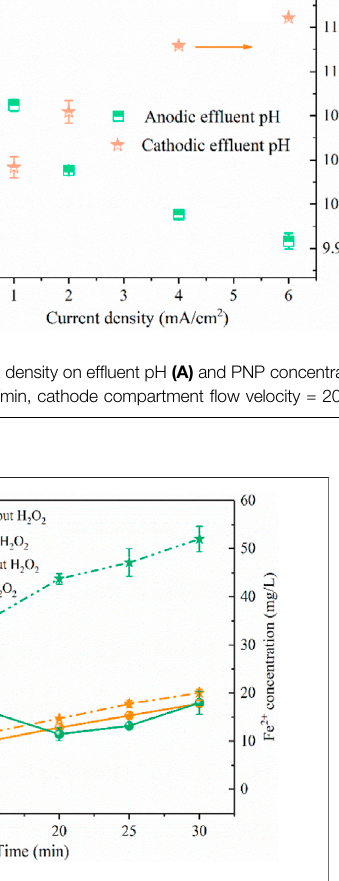
FIGURE 3 | Concentration variations of iron ions under different conditions. (PNP (cid:1) 100 mg/L, Na 2 SO 4 (cid:1) 3 g/L, pH 0 (cid:1) 3.0).